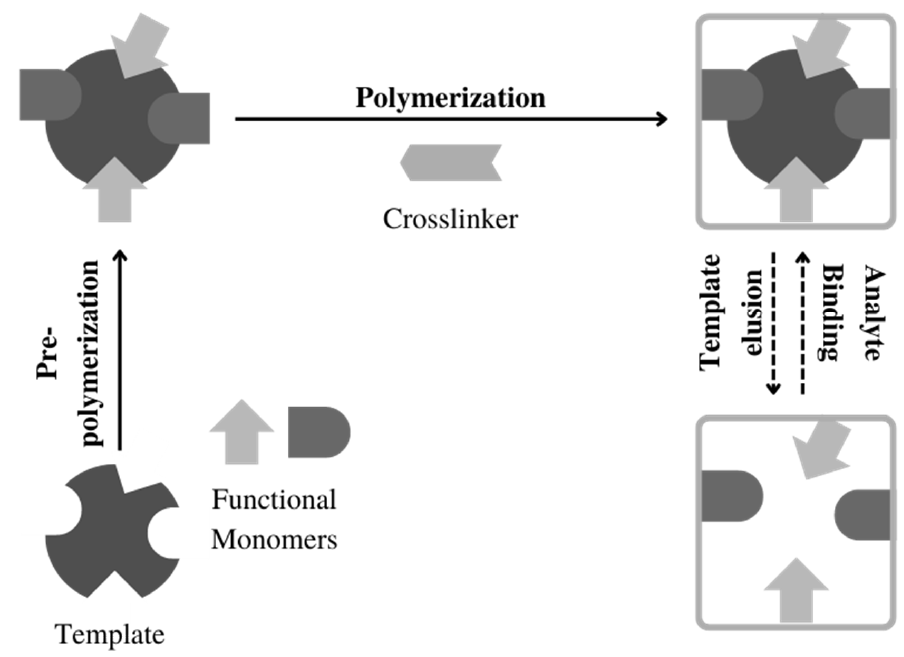
Figure 2. Illustration of the polymerization process of dual-functional monomer MIPs.